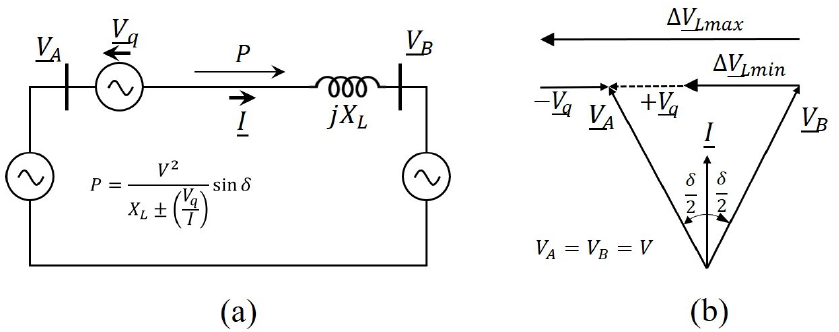
Figure 12. Transmission line compensation with an SSSC. ( a ) Single-phase equivalent circuit. ( b ) Phasor diagram